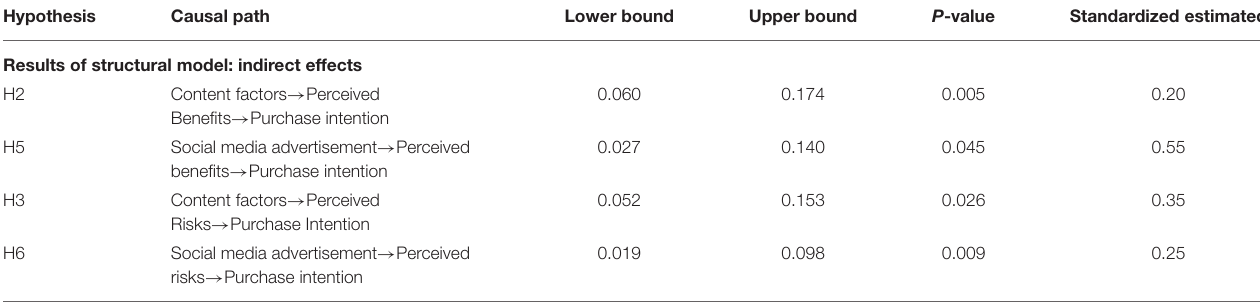
TABLE 7 | Indirect findings of the